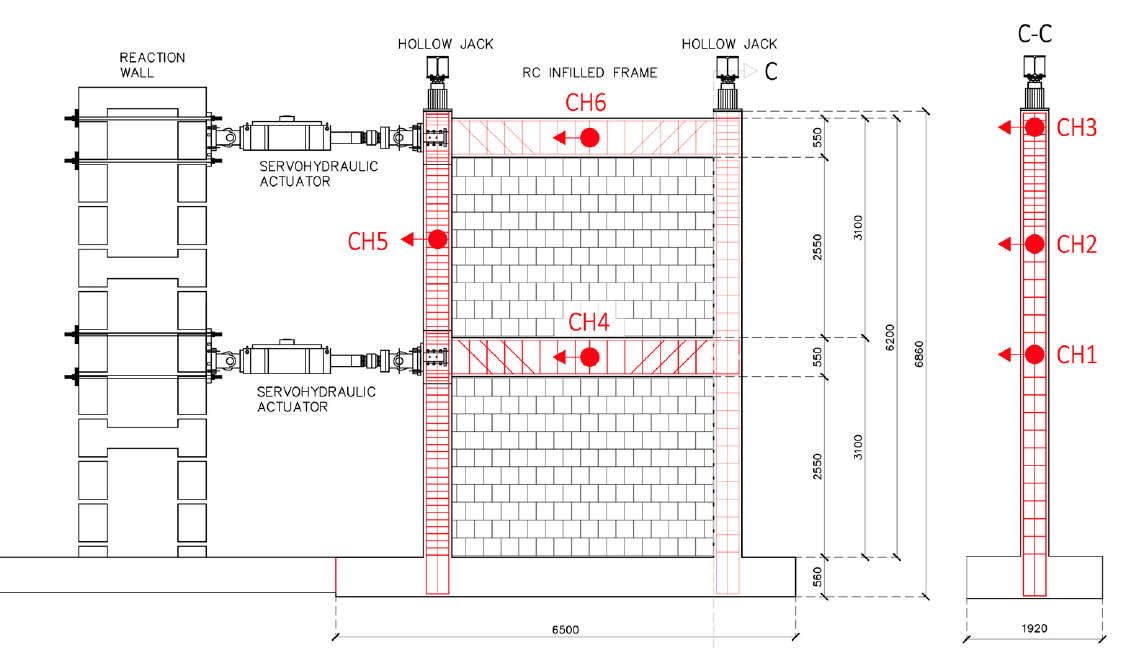
Figure 3. Pseudo-dynamic test setup and accelerometers layout for output-only modal identification tests, dimensions in mm.